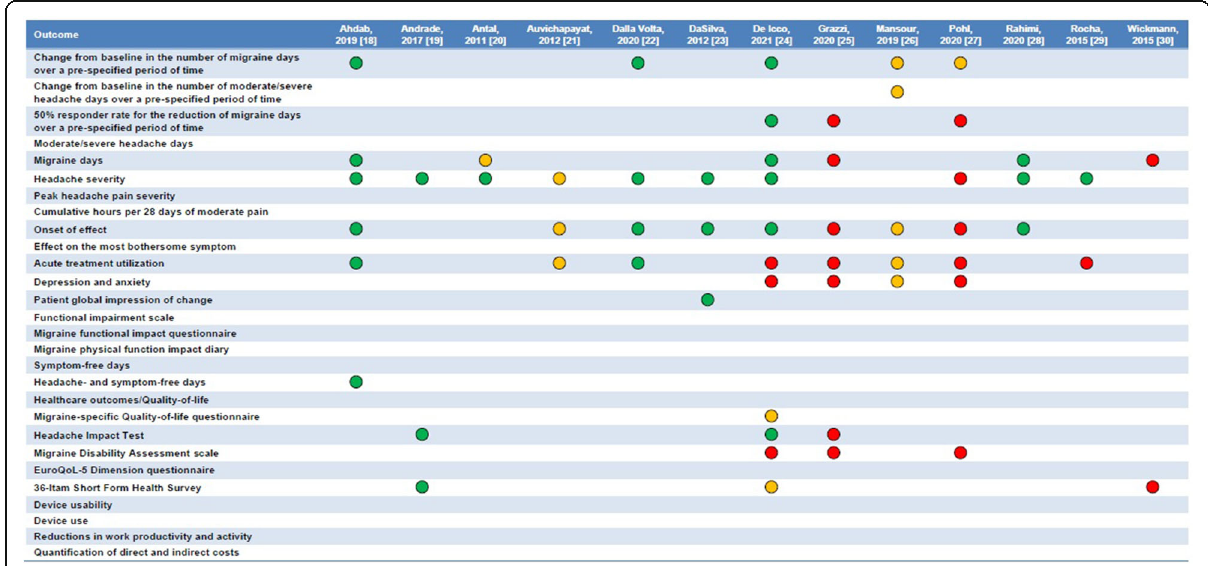
Fig. 5 Results of the available randomized controlled trials comparing transcranial direct current stimulation to sham procedure. The list is taken from the guidelines of clinical trials of neuromodulation devices for the treatment of migraine in adults [14]. More detailed quantitative reports are provided in Supplemental file 1. Green circles indicate that tDCS was entirely superior to sham, amber circles that tDCS was partially superior to sham, red circles that tDCS was note superior to sham; cells were left empty if outcomes were not